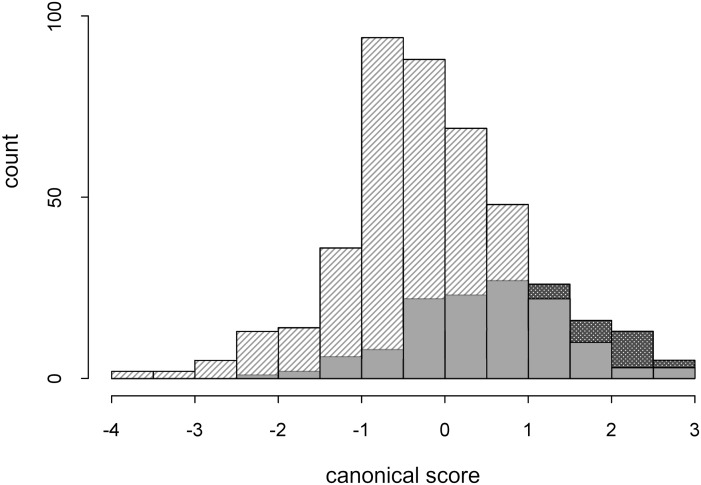
Discriminant analysis of two groups (DA)—Stepwise forward selection using basic modelling (Bioclim algorithm).Bioclimatic data related to the ploidy levels (diploid and tetraploid) of individual populations—stratified data. The features contributing the most to the variability were BIO3, 5 and 17; striped area—tetraploid cytotype, dotted area—diploid cytotype, grey area—overlapping of both cytotypes.